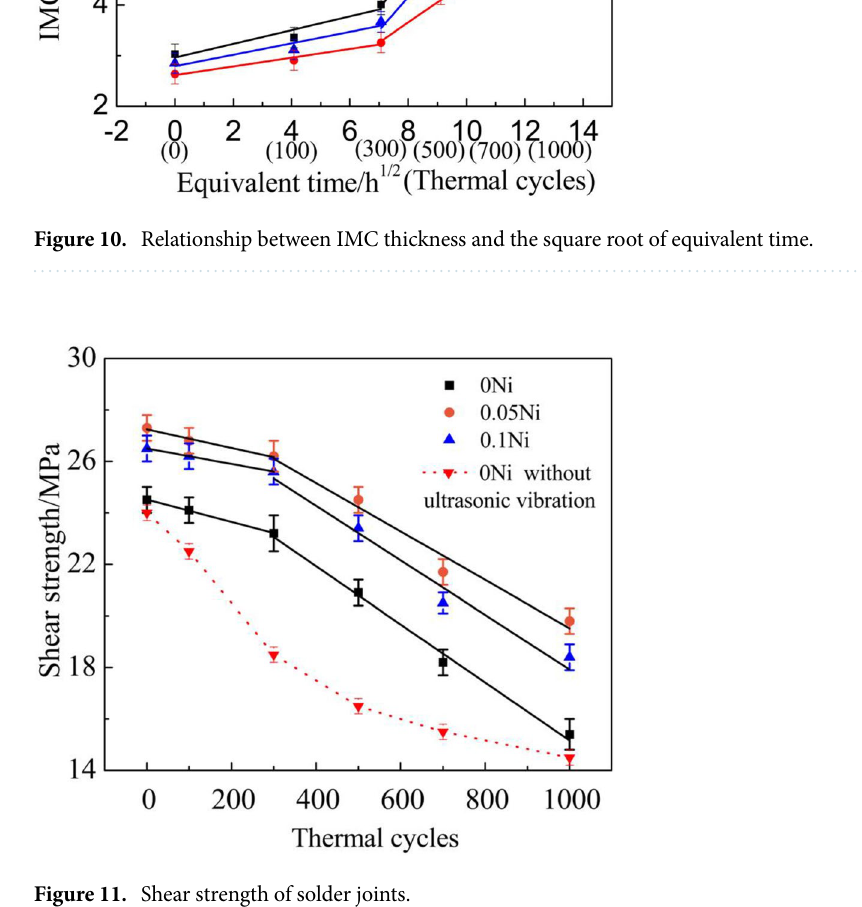
Figure 11. Shear strength of solder